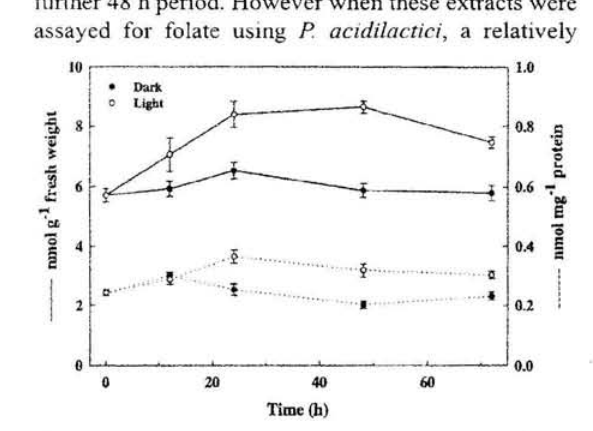
Figure 3 Levels of short-chained folates in etiolated and greening leaves. Extracts of etiolated and green- ing leaves were assayed for folates with L. rhamnosus before and after GGH treatment. Data are expressed as means +SEM, n ^ 9. expressed as means ±SEM, n=9. large proportion of methylated and/or oxidized folate was indicated. Thus the mitochondrial folate of 9 d etiolated plants was 48.9+4.1% methylated and/or oxi- dized while that of the controls was 52.1±3.4% of this folate type. In contrast, mitochondria isolated from greening seedlings had higher folate concentrations on